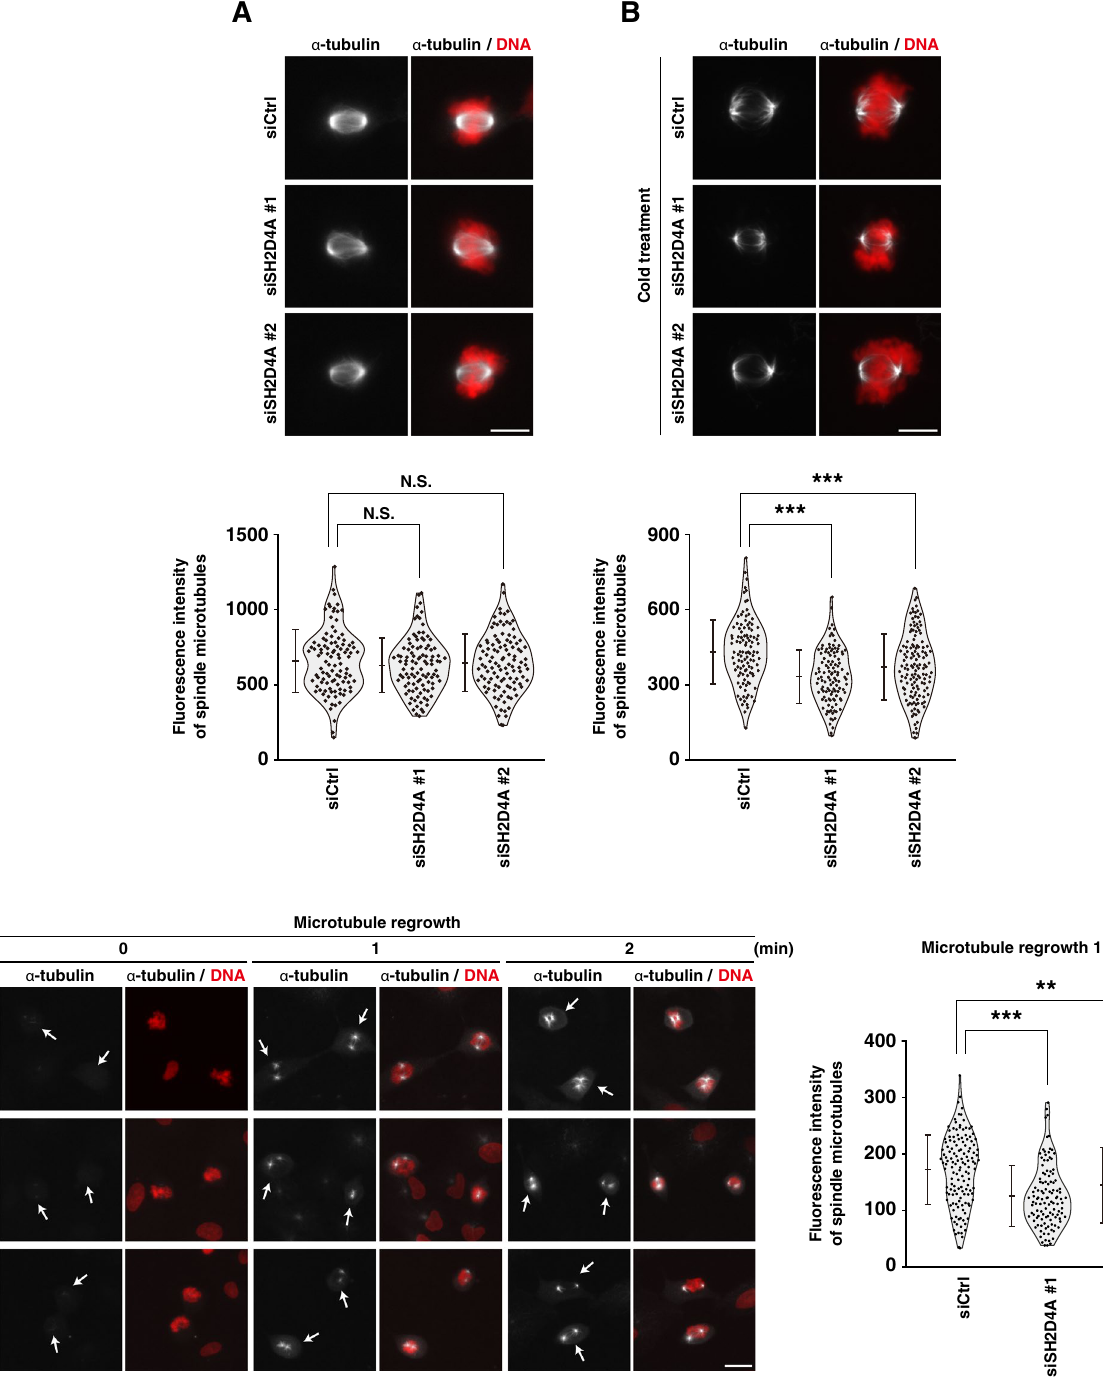
Figure 3. SH2D4A regulates the spindle formation at prometaphase. A549 cells were transfected with control siRNA (siCtrl) or SH2D4A-targeting siRNAs (siSH2D4A #1 and #2). At 28 h after siRNA transfection, cells were treated with 6 µM RO-3306 for 20 h. ( A , B ) RO-3306-treated cells were washed with PBS(+) and cultured in fresh media for 15 min. Before ( A ) or after ( B ) incubation on ice for 5 min, cells were fixed and stained for α-tubulin (gray) and DNA (red). (Upper panels) Representative images of prometaphase cells are shown. Scale bar, 10 µm. (Lower panels) The fluorescence intensity of α-tubulin was measured and plotted as the mean ± SD from a representative experiment of two independent experiments (n > 102). Violin plots with data points are also shown. ( C ) RO-3306-treated cells were washed with PBS(+), cultured in fresh media for 10 min, and incubated on ice for 4 h. Before or after incubation at 37 °C for 1 or 2 min, cells were fixed and stained for α-tubulin (gray) and DNA (red). (Left) Representative images are shown, and the white arrows indicate the prometaphase cells. Scale bar, 10 µm. (Right) In the cells incubated at 37 °C for 1 min, the fluorescence intensity of α-tubulin was measured and plotted as the mean ± SD from a representative experiment of two independent experiments (n > 106). Violin plots with data points are also shown. Asterisks indicate significant differences (Dunnett’s test, ** p < 0.01, *** p < 0.001; N.S., not